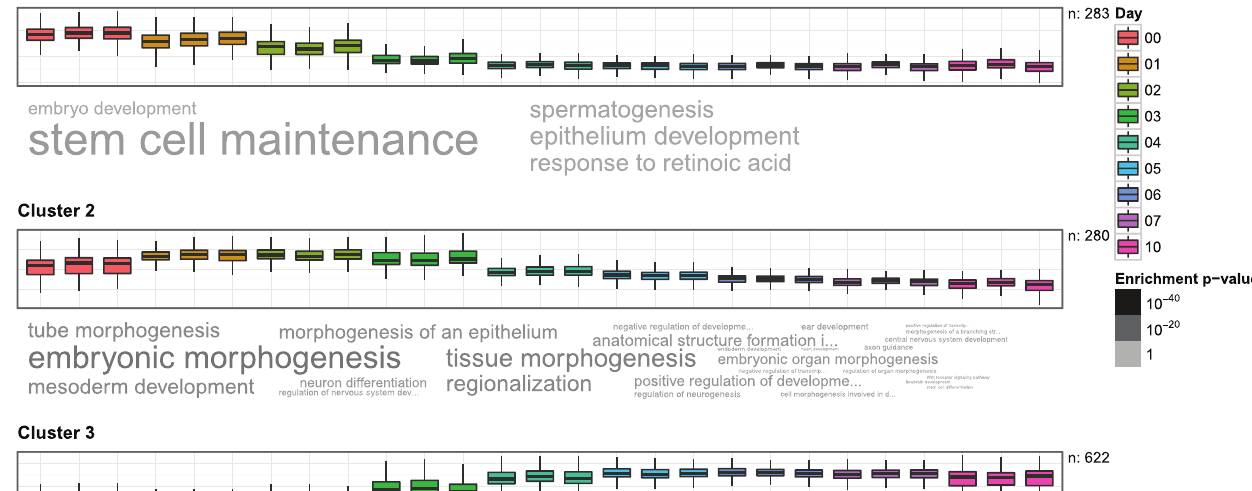
Figure 2. GOsummaries representation of k-means clustering results. Each cluster is described by a boxplot showing expression of the genes and a word cloud showing the most significant GO results. In the boxplot, each box corresponds to one sample and the y-axis shows the expression values. In the word clouds the size of the words is proportional to - log absolute enrichment strength of terms (words) is color-coded in